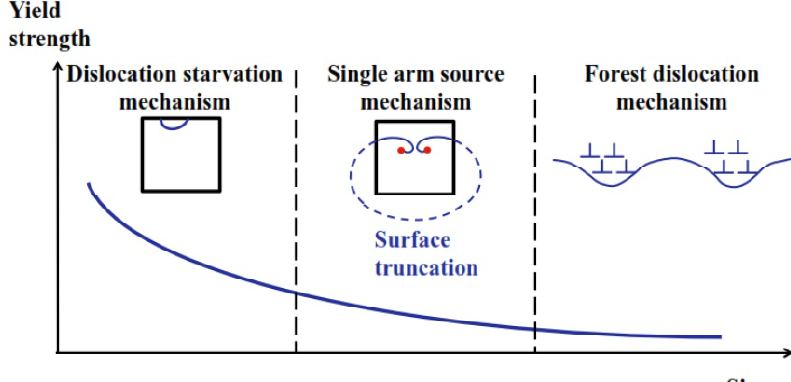
Fig. 19. Plastic deformation mechanisms in FCC single crystal. Reprinted with permission from Y. Cui 2017. The Investigation of Plastic Behavior by Discrete Dislocation Dynamics for Single Crystal Pillar at Submicron Scale, [222]: (c) Springer